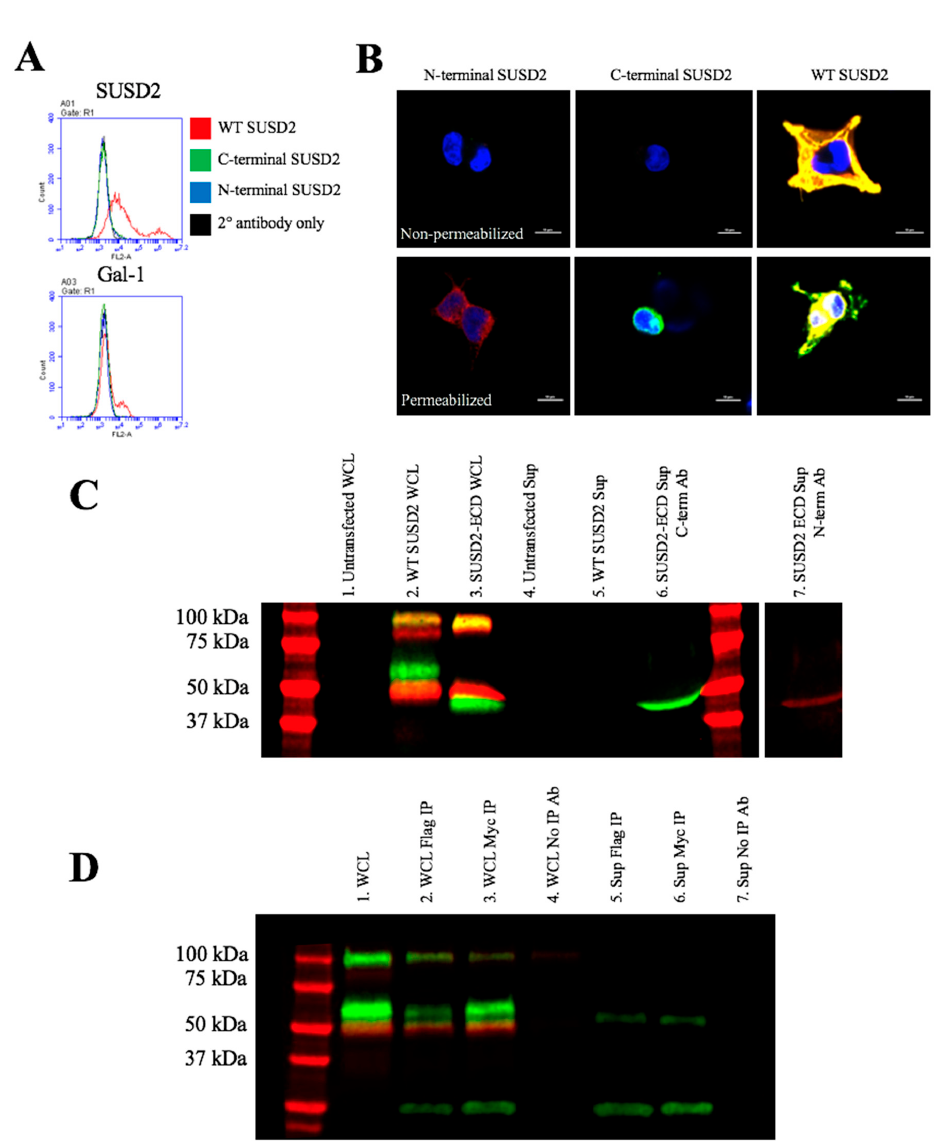
Figure 6. Flow cytometry and immunofluorescence analysis of N- and C-terminal fragments of SUSD2. ( A ) Flow cytometry analysis of N- and C-terminal SUSD2 fragments and Gal-1 plasma membrane localization. 293T cells were not permeabilized. The anti-N-terminal SUSD2 antibody was used to label 293T cells transiently transfected with N-terminal, C-terminal, or WT SUSD2. The anti-Gal-1 antibody was used to detect cell surface Gal-1. ( B ) Immunofluorescence confocal microscopy was utilized to determine the localization of N- and C-terminal fragments. Cells were fixed with 2% paraformaldehyde and permeabilized with 0.2% Triton X-100 before staining with anti-N-terminal (red) or anti-C-terminal (green) SUSD2 antibodies. Yellow indicates the colocalization of both fragments. ( C ) Western immunoblot analysis of SUSD2 in cell supernatants. 293T cells were transiently transfected with expression constructs encoding WT SUSD2 or SUSD2 ‐ ECD. The SUSD2 ‐ ECD is a positive control for secretion. Supernatants and whole cell lysates (WCL) were harvested 48-h post-transfection and analyzed by western immunoblot. Supernatants and WCL were separated by SDS-PAGE and probed for SUSD2 using anti-C-terminal (green) and anti-N-terminal (red) SUSD2 antibodies. ( D )ImmunoprecipitationanalysisofFLAG-SUSD2-Mycincellsupernatants. 293Tcellswere transiently transfected with pFLAG-SUSD2-Myc. After 48 h, WCL and supernatants were harvested. Immunoprecipitation was performed using anti-FLAG or anti-Myc antibodies. Immunoprecipitated proteins from supernatants and WCL were separated by SDS-PAGE and probed for SUSD2 using anti-C-terminal (green) and anti-N-terminal (red) SUSD2